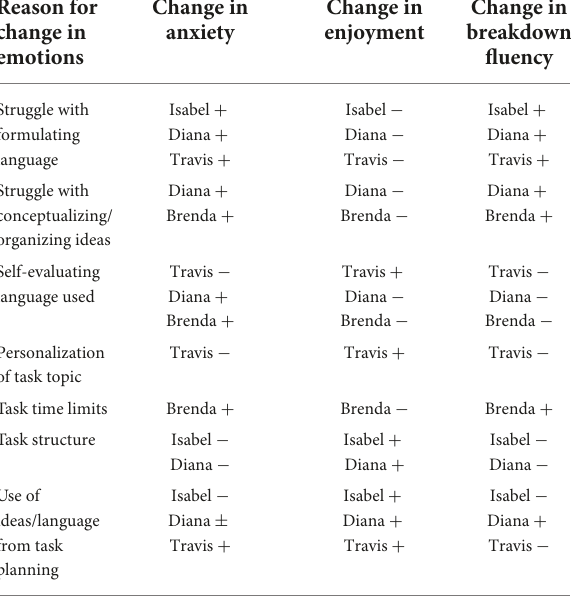
TABLE 3 Perceived factors leading to change in emotions and breakdown fluency during the